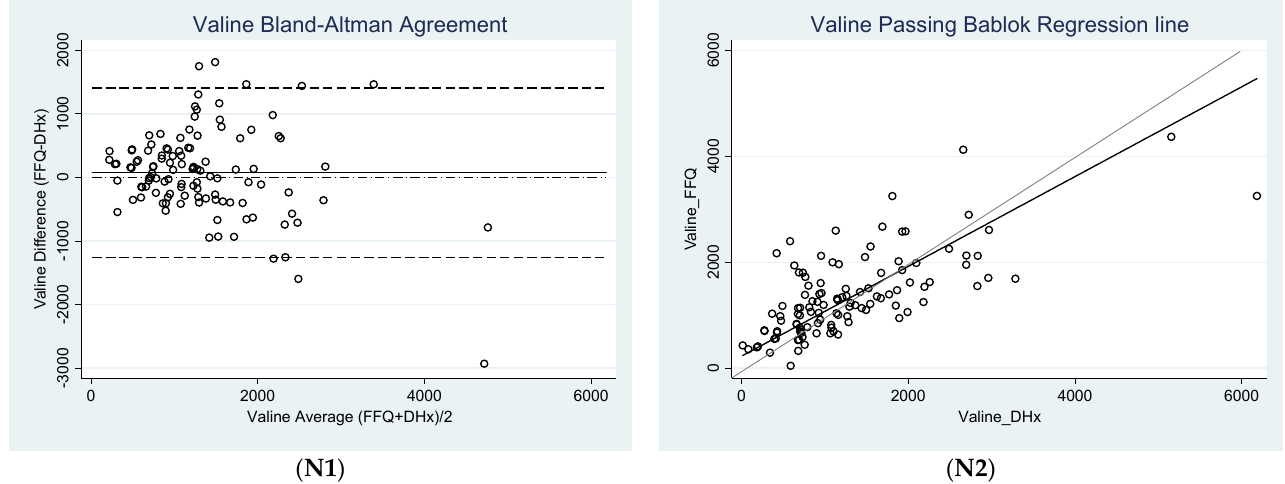
Figure 1. 1: Bland-Altman plots showing agreement between the reference method diet history (DHx) and Food Frequency Questionnaire (FFQ) 2: Passing Bablok analysis showing constant difference and proportional difference (black line) against line showing 100% agreement between the two methods (grey line) for ( A ) copper, ( B ) iron, ( C ) zinc, ( D ) retinol equivalents, ( E ) vitamin C, ( F ) cholecalciferol, ( G ) vitamin E, ( H ) alpha linolenic acid (ALA), ( I ) total long chain omega-3 fatty acids (LC n -3 FA), ( J ) arginine, ( K ) glutamine, ( L ) isoleucine, ( M ) leucine, ( N ) valine.